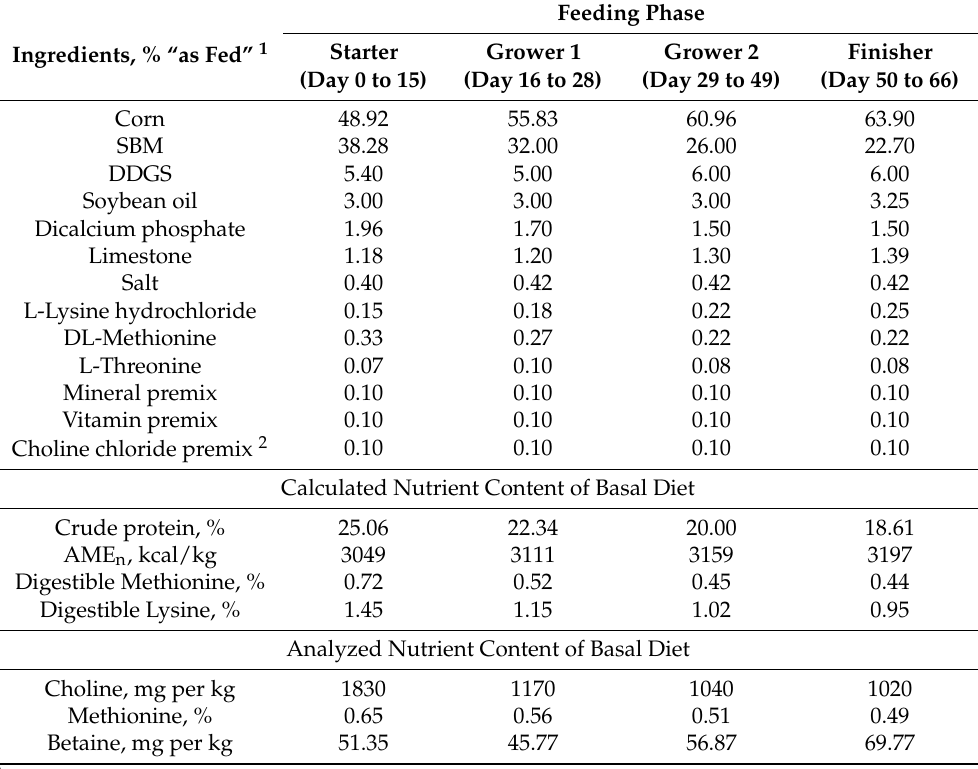
Table 1. Ingredient and nutrient composition of the basal broiler chicken diets.